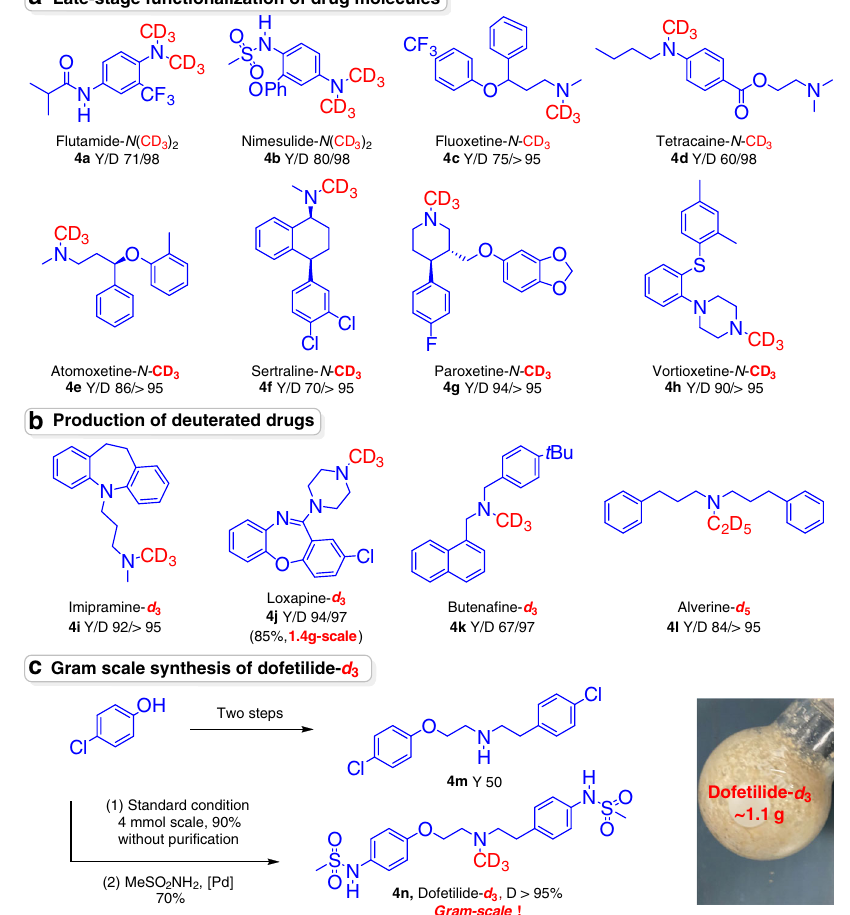
Fig. 4 Late-stage functionalization and preparation of deuterated drugs. a Late-stage functionalization of drug molecules. b Production of deuterated drugs. c Gram-scale synthesis of dofetilide- d 3